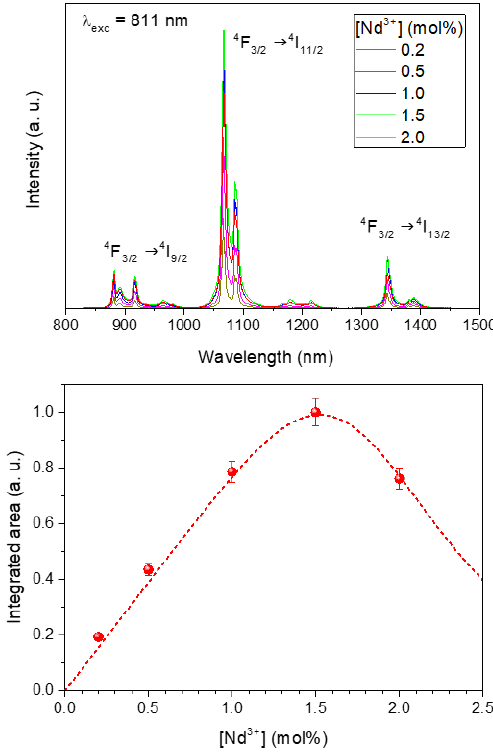
Figure 4. ( Top ) Emission spectra of the Nd:LuVO 4 nanoparticles with different Nd 3+ content. ( Down ) Integrated intensity of the emissions vs. the Nd 3+ doping level. Line is a guide for the eye. Error bars have been included. Nanomaterials 2020 , 10 , x FOR PEER REVIEW